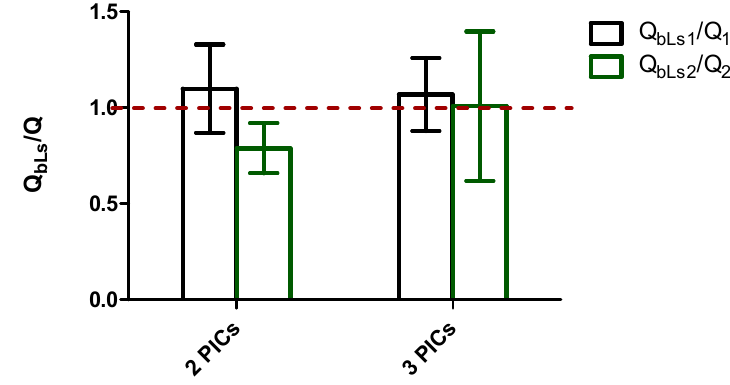
Figure 7. Accuracy of measured emission Q integrated concentration data